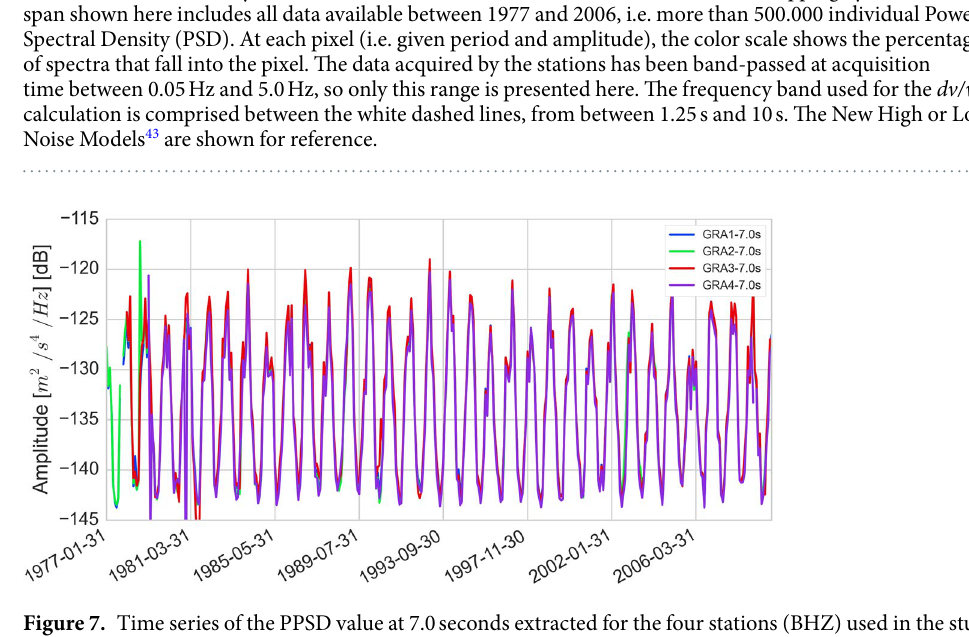
Figure 7. Time series of the PPSD value at 7.0 seconds extracted for the four stations (BHZ) used in the